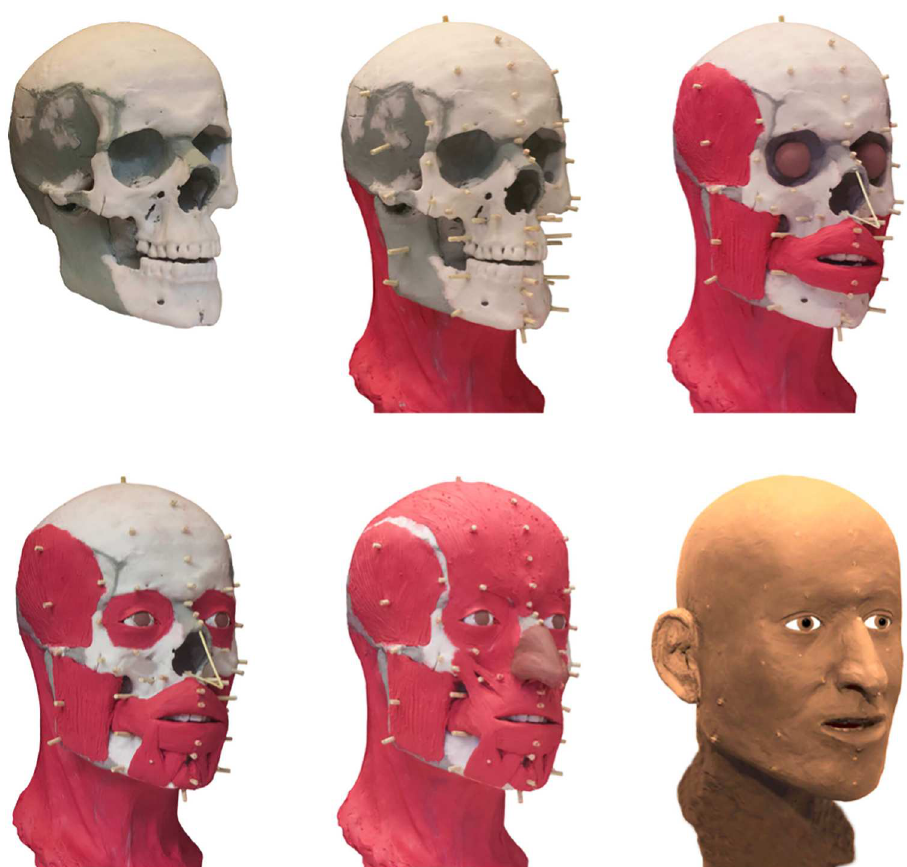
Fig 10. Different stages of the facial reconstruction.